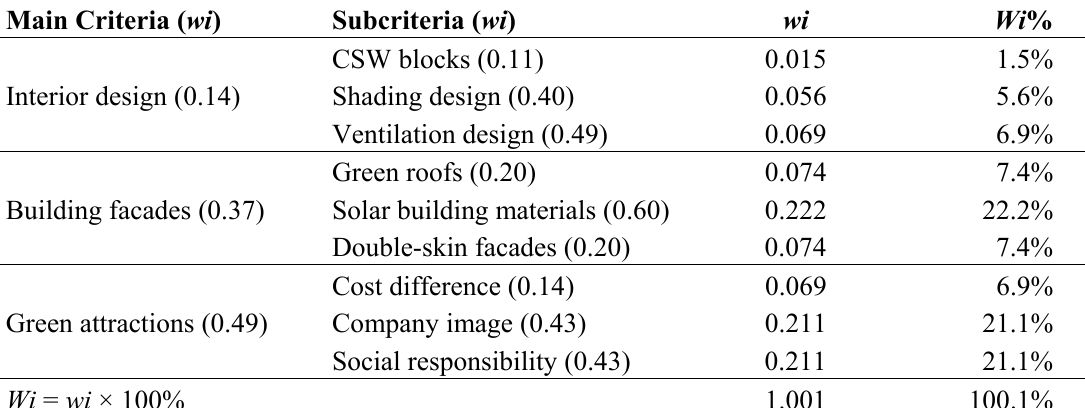
Table 5. Weighting value of each